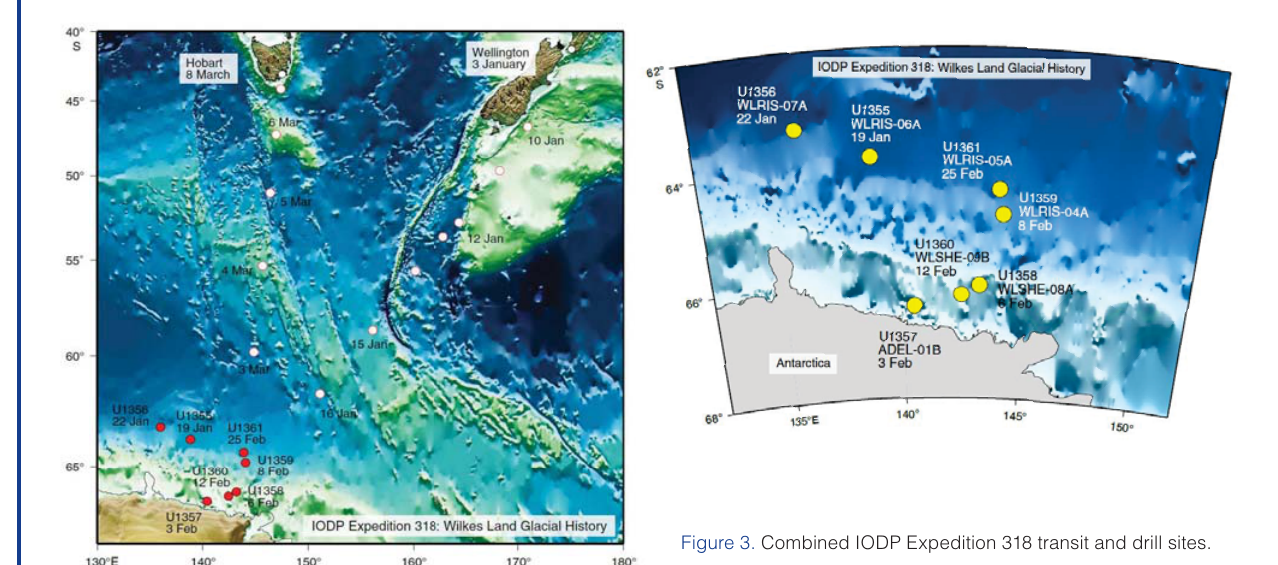
Figure 3. Combined IODP Expedition 318 transit and drill